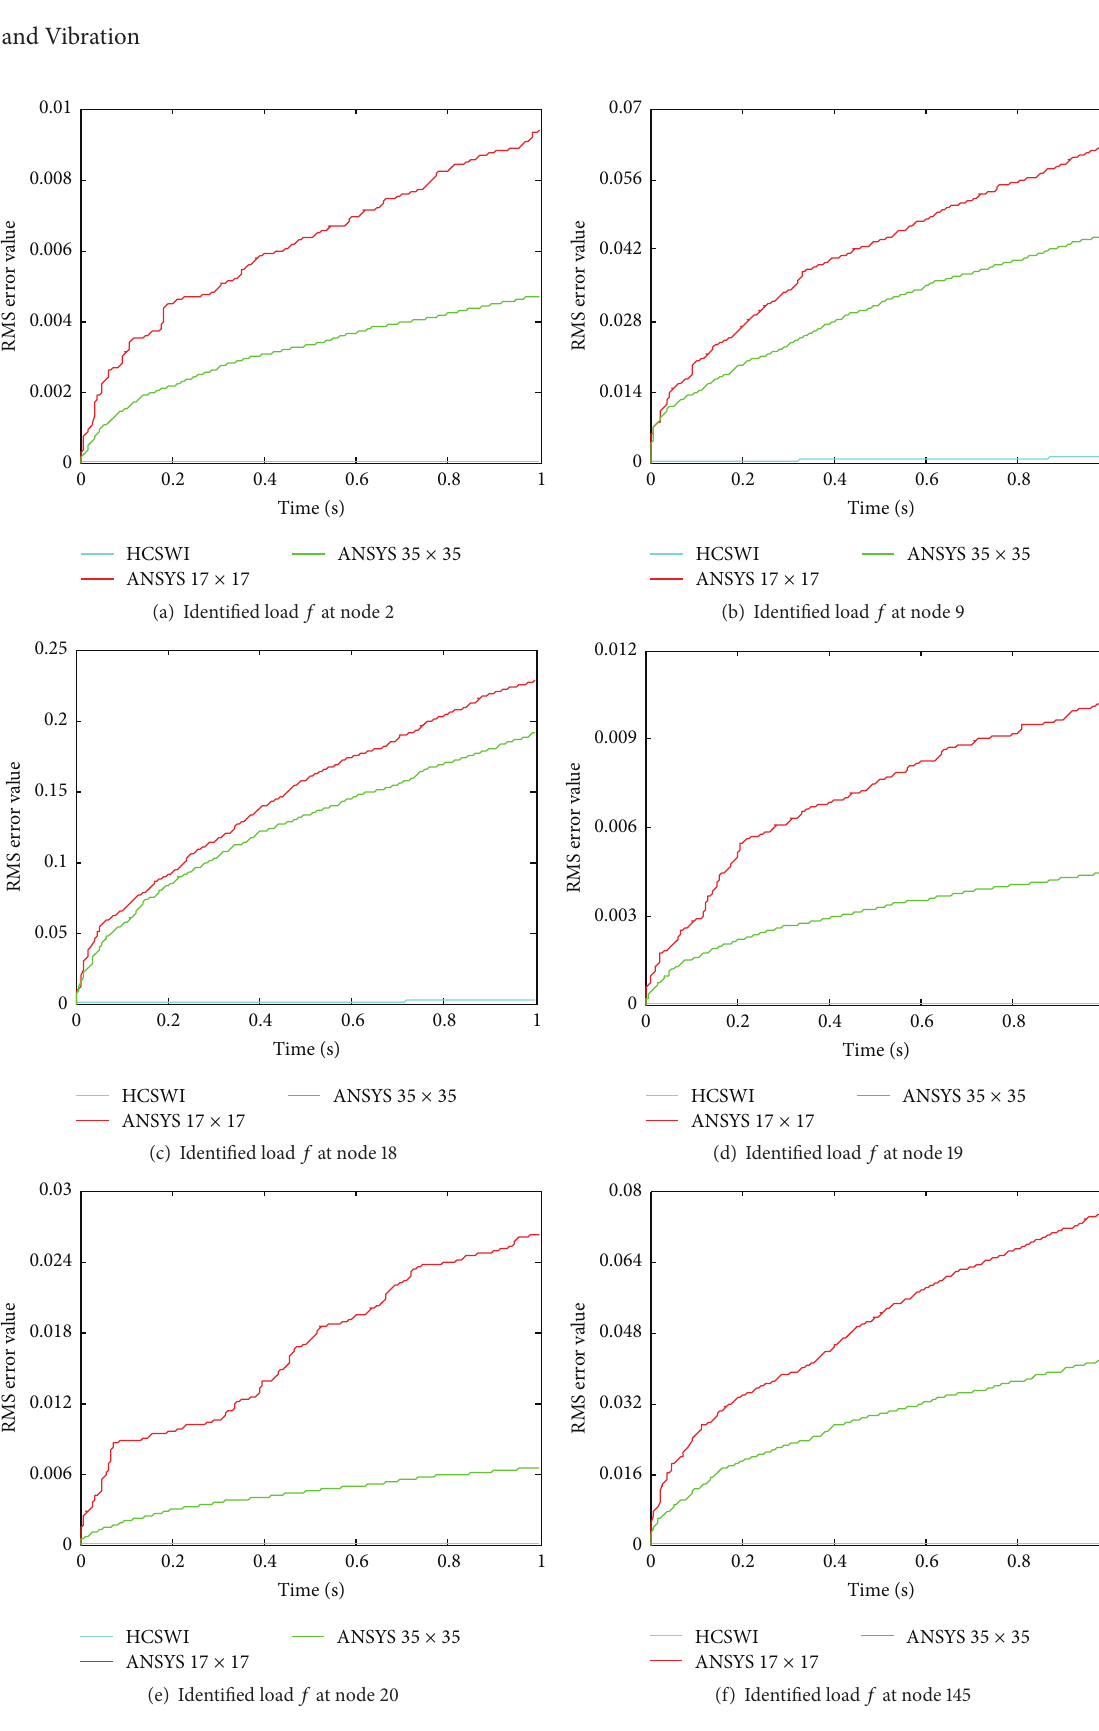
Figure 10: The root mean square error value with the excitation 𝑓 applied at node